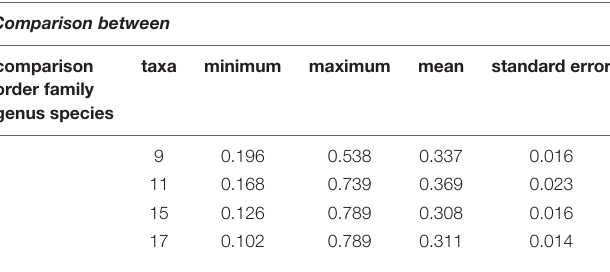
TABLE 3 | Summary of genetic divergence (Kimura 2-parameter %) between taxonomic levels. Comparison between comparison order